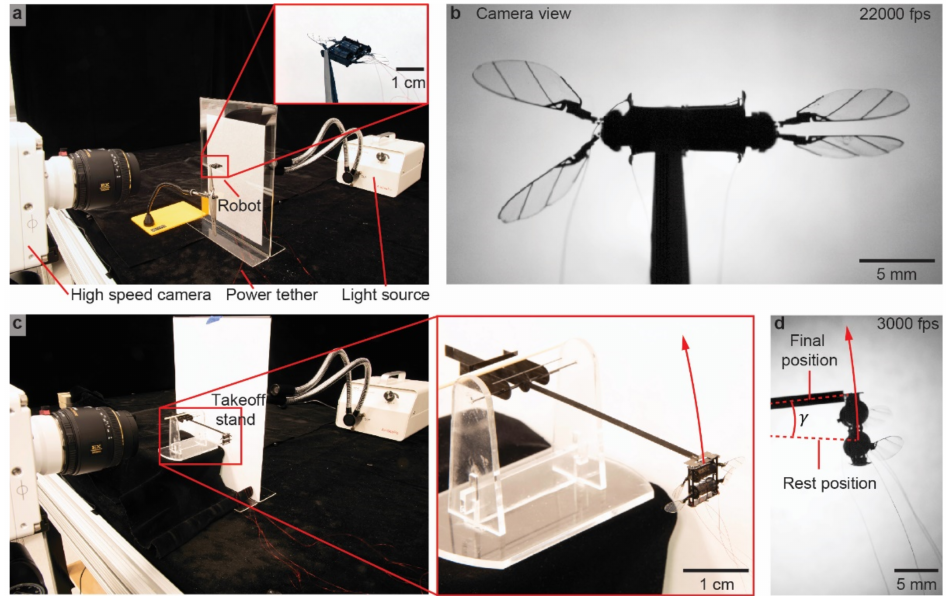
Figure 3. Experimental setup for measuring the robot flapping kinematics and mean lift force. ( a ) Setup of a static flapping-wing experiment. A backlight illuminates the robot, and the flapping- wing motion is captured by a high-speed camera at 22,000 fps. ( b ) A sample image that is captured by the high-speed camera when the robot operates at 350 Hz. ( c ) Setup of robot liftoff experiments. The red inset shows a robot is installed on the liftoff test stand. ( d ) A sample image that is captured by the high-speed camera during robot